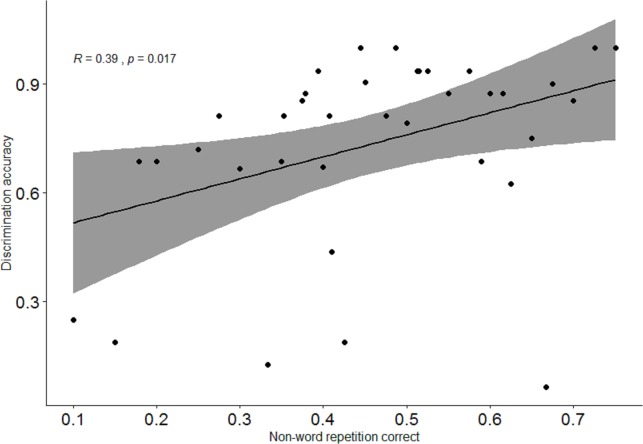
Correlations between discrimination accuracy and non-word repetition task (aggregated participant results).Confidence interval is shown in grey.